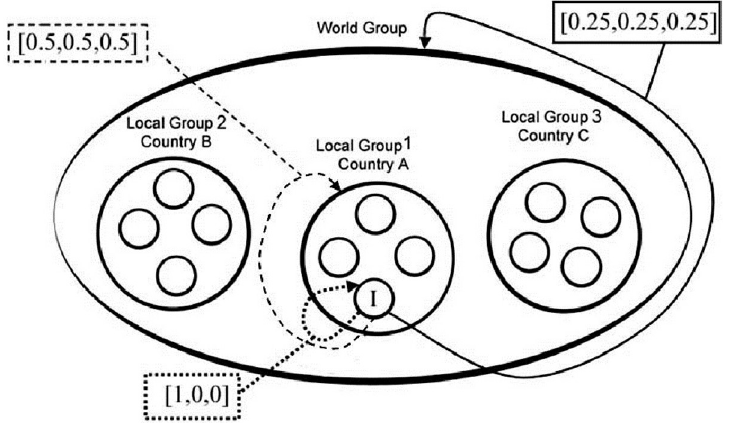
Fig 2. Representation of the nested social dilemma. I stands for “Individual”. ‘Local 1’, ‘Local 2’, ‘Local 3’ represent groups of people residents in the same locality in three different countries. Individuals have three options on how to allocate their endowments of 10 tokens: allocating to a personal account, to their local account, and to the global account, which comprises the three lower-level local accounts. Contributions to the personal account are transferred one-to-one onto an individual’s payoff. Contributions to one’s local account are multiplied by a factor of two and divided among four local residents. Contributions to the global accounts are multiplied by a factor of three and divided evenly among the 12